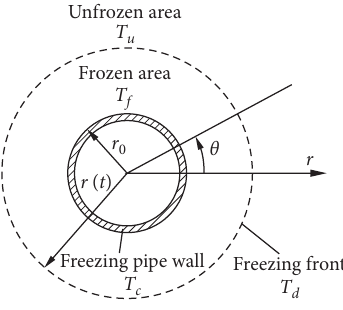
Figure 6: Schematic diagram of single tube